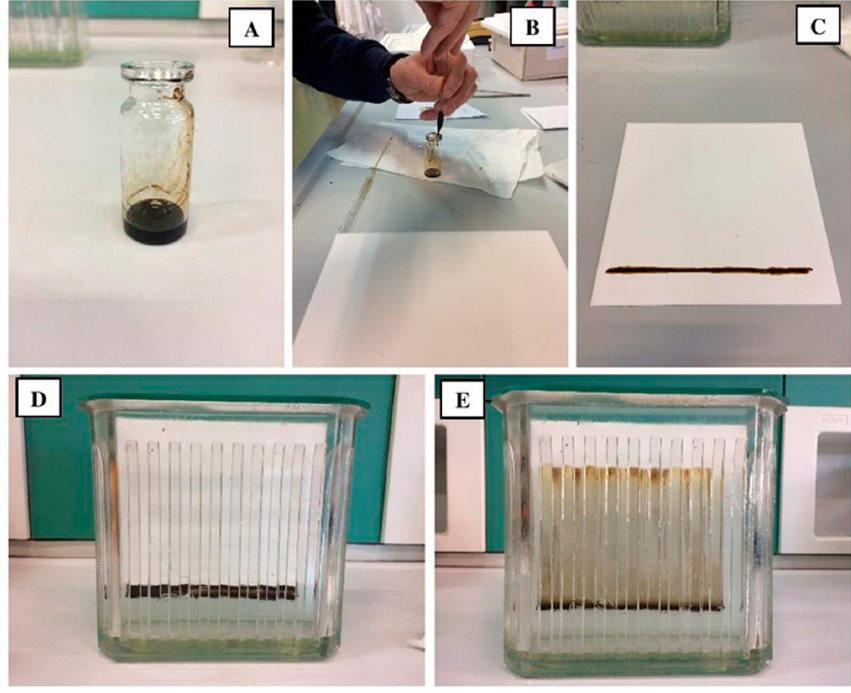
Figure 2. TLC technique procedure in chronology ( A – E ).